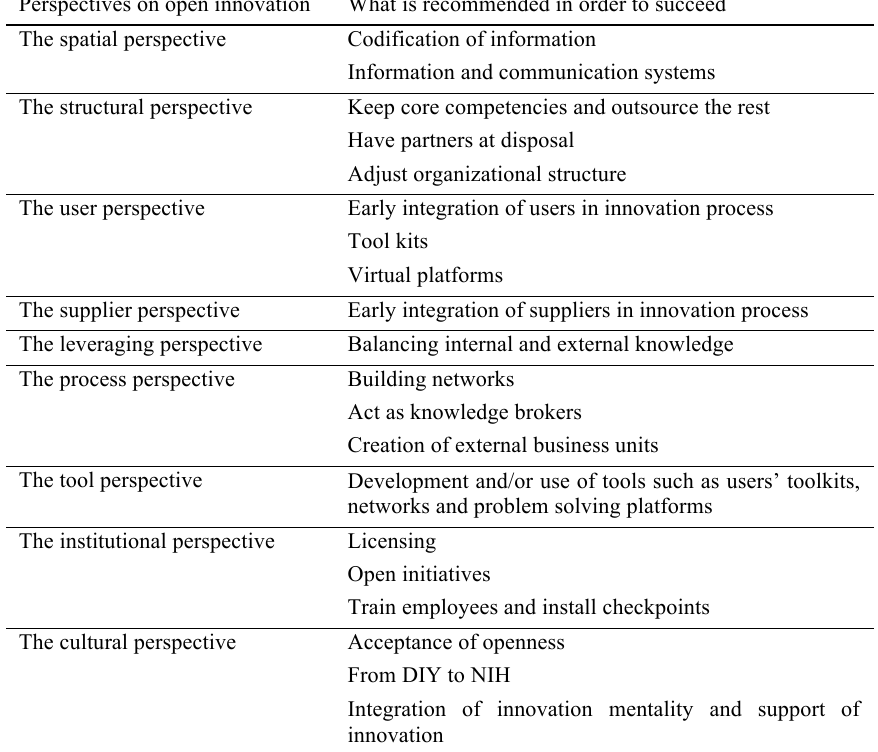
Table 2. Perspective on OI vs. recommendations to succeed Perspectives on open